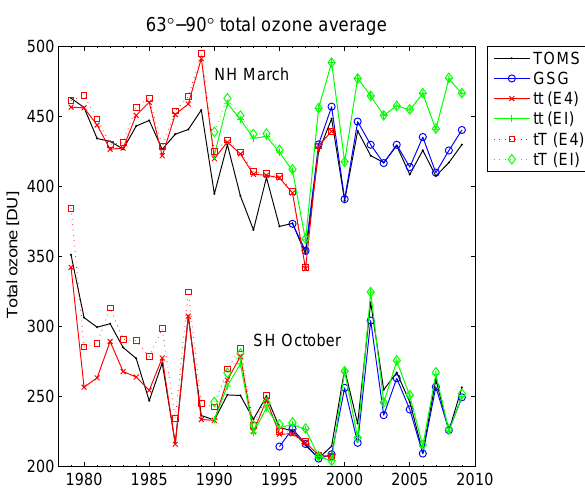
Fig. 3. Springtime polar TO3 from model runs with EESC- dependent chemistry, as compared to the TOMS/SBUV merged TO3 dataset (“TOMS”) and the GOME/SCIAMACHY/GOME2 merged datasets (“GSG”). In addition to the tt model runs us- ing a polar chemistry scheme scaled linearly with EESC, also the tT model runs are shown, which use a polar chemistry ∝ EESC 2 . Model runs are performed in two periods, 1979–1999 using ERA- 40 wind fields (“E4”), and 1990–2009 using ERA-Interim (“EI”). The climatological ozone column below 330K has been added to modelled